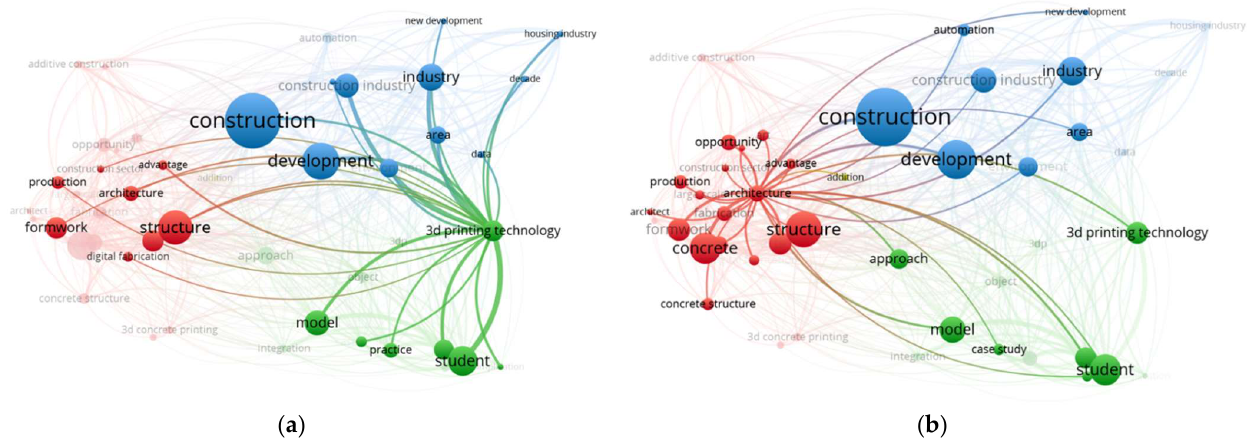
Figure 4. Connections with different terms and clusters in the network of analyzed literature sample for terms: ( a ) “3D printing technology” and ( b ) “architecture”.